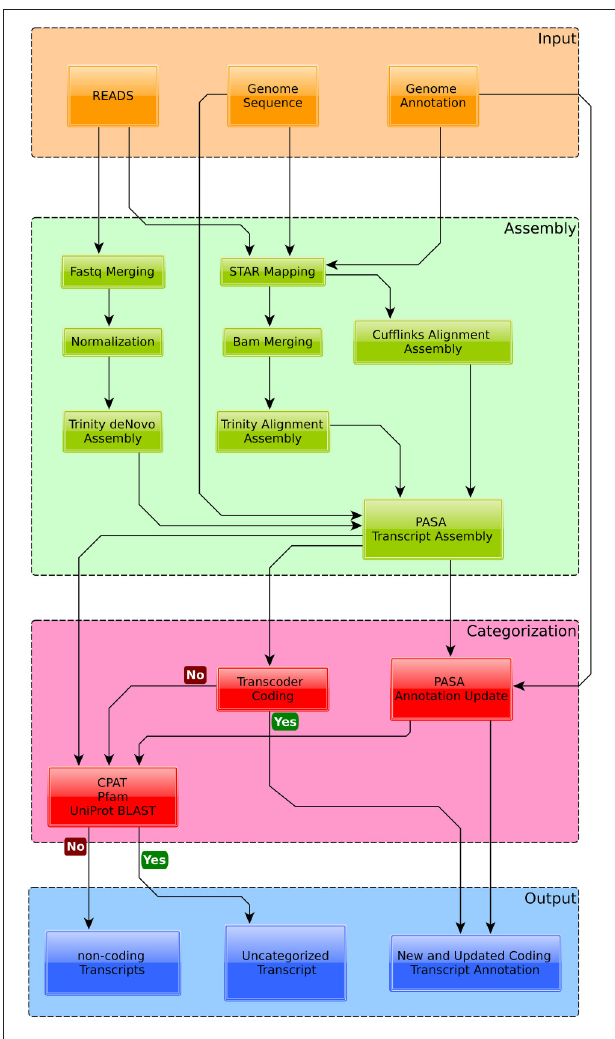
FIGURE 2 | Overview of the annotation pipeline used to augment the current genome annotation of Exophiala dermatitidis . Transcripts were assembled with Trinity and Cufflinks and mapped back to the genome with PASA. Transcripts overlapping with Exophiala dermatitidis coding regions were used to find new splice variants and (re-)annotate UTRs. Transcripts that were considered coding by Transdecoder were classified as new proteins. The other transcripts were tested for their coding potential with CPAT, Pfam and by blasting them against Uniprot in order to differentiate between truly non-coding transcripts and non-coding transcripts with coding